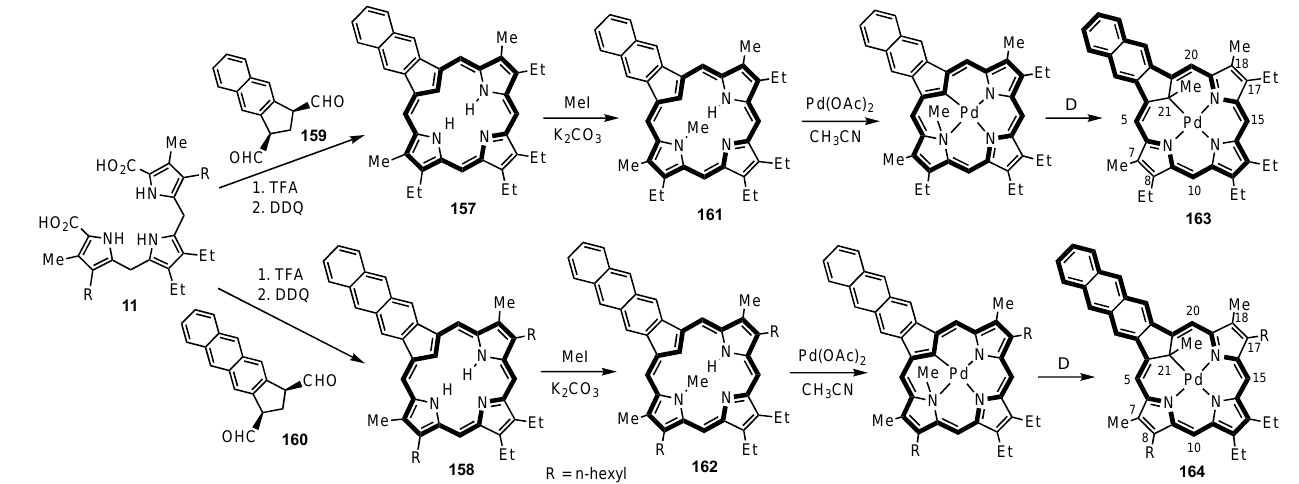
Figure 6. Carbaporphyrin tautomers and extended aromatic conjugation pathways in palla- dium(II) complexes.